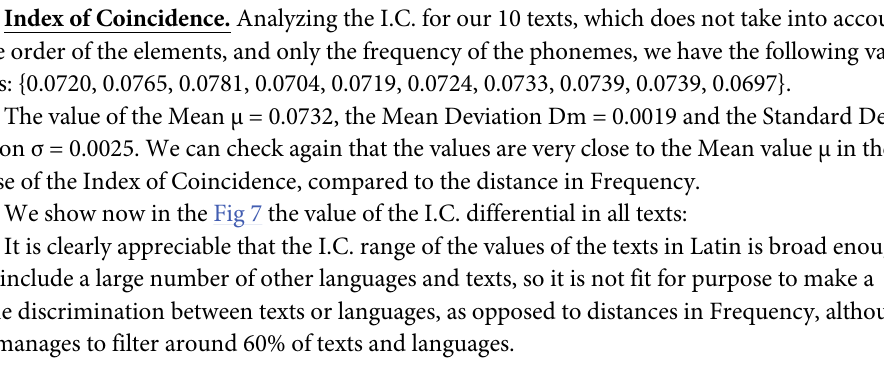
PLOS ONE | https://doi.org/10.1371/journal.pone.0213710 March 19,